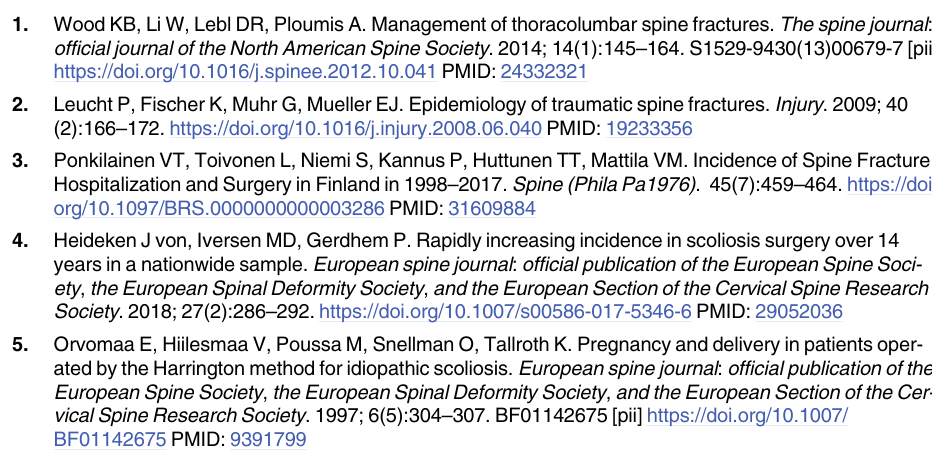
S1 Table. Definitions for ICD-10-codes and NOMESCO classification codes for fracture- related and other major spine operations included in this study. S2 Table. Frequencies of the spine operations and the mean age of the women at the time of operation in these subgroups during the study period. S1 Fig. DAG: Health of neonate as a dependent variable. S2 Fig. DAG Risk for caesarean section as a dependent variable.